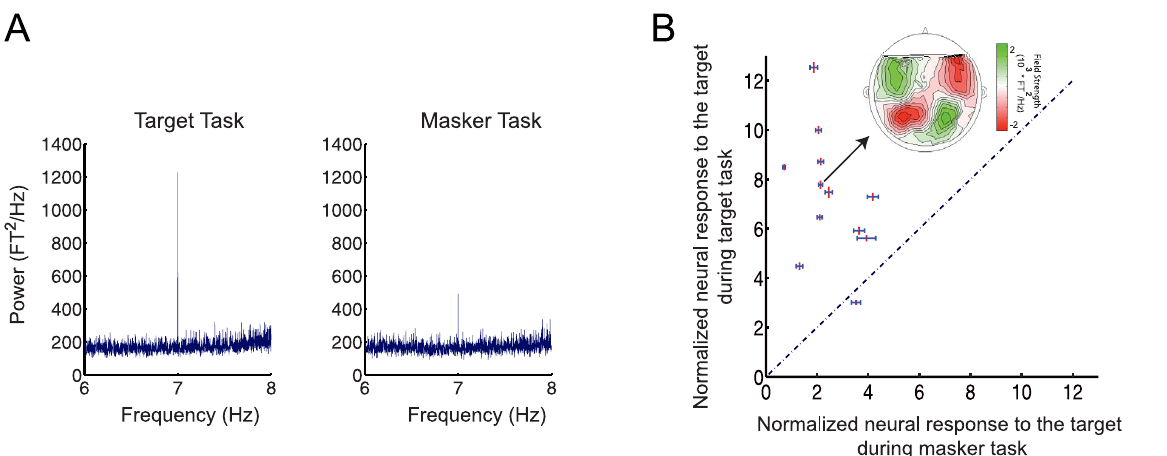
Fig. 3. Attention modulates the normalized neural response. (A) The power at the target sequence rate is larger in the target task compared to the masker task (MEG experiment D, N 5 12, 20 best channels selected for each participant, see Methods for details). (B) Normalized neural response to the target sequence for each participant is plotted in target-masker normalized response space for each participant. The normalized neural response is computed as the ratio of the neural response power at the target sequence rate (7 Hz) to the average power of the background neural activity (from 6–8 Hz). Error bars represent the standard error for the target task (red, orthogonal bars) and the masker task (blue, horizontal bars). Inset: the MEG magnetic field distributions of the target rhythm response component for a single participant, with red and green representing the target magnetic field strength projected onto a line with constant